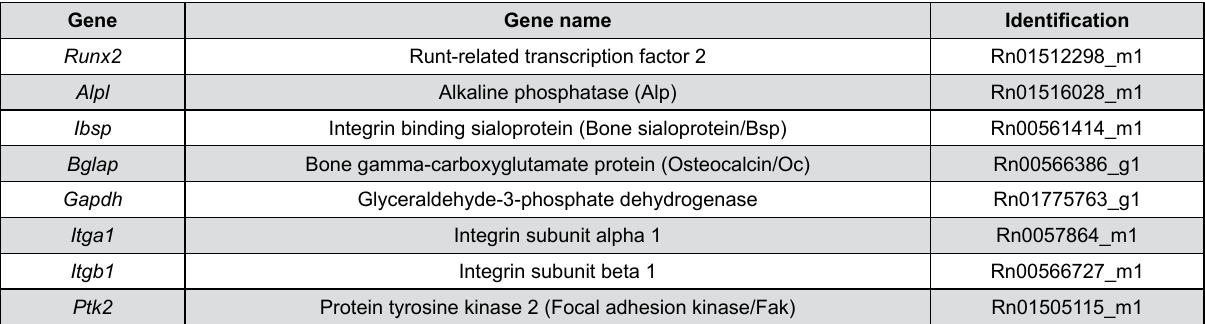
Figure 1- TaqMan (Life Technologies-Invitrogen) probes for real-time